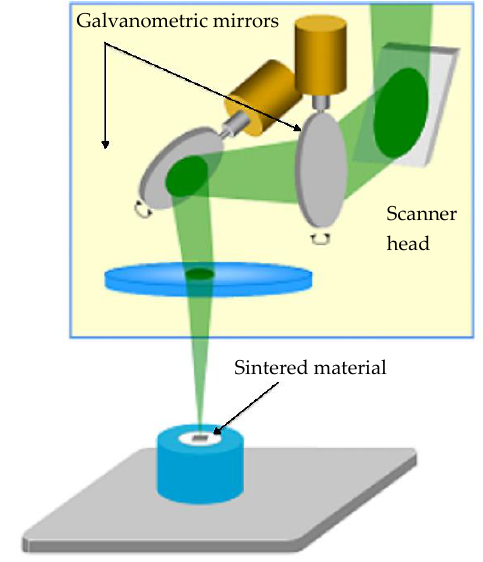
Figure 2. Laser treatment of ceramic surfaces: experimental set-up.